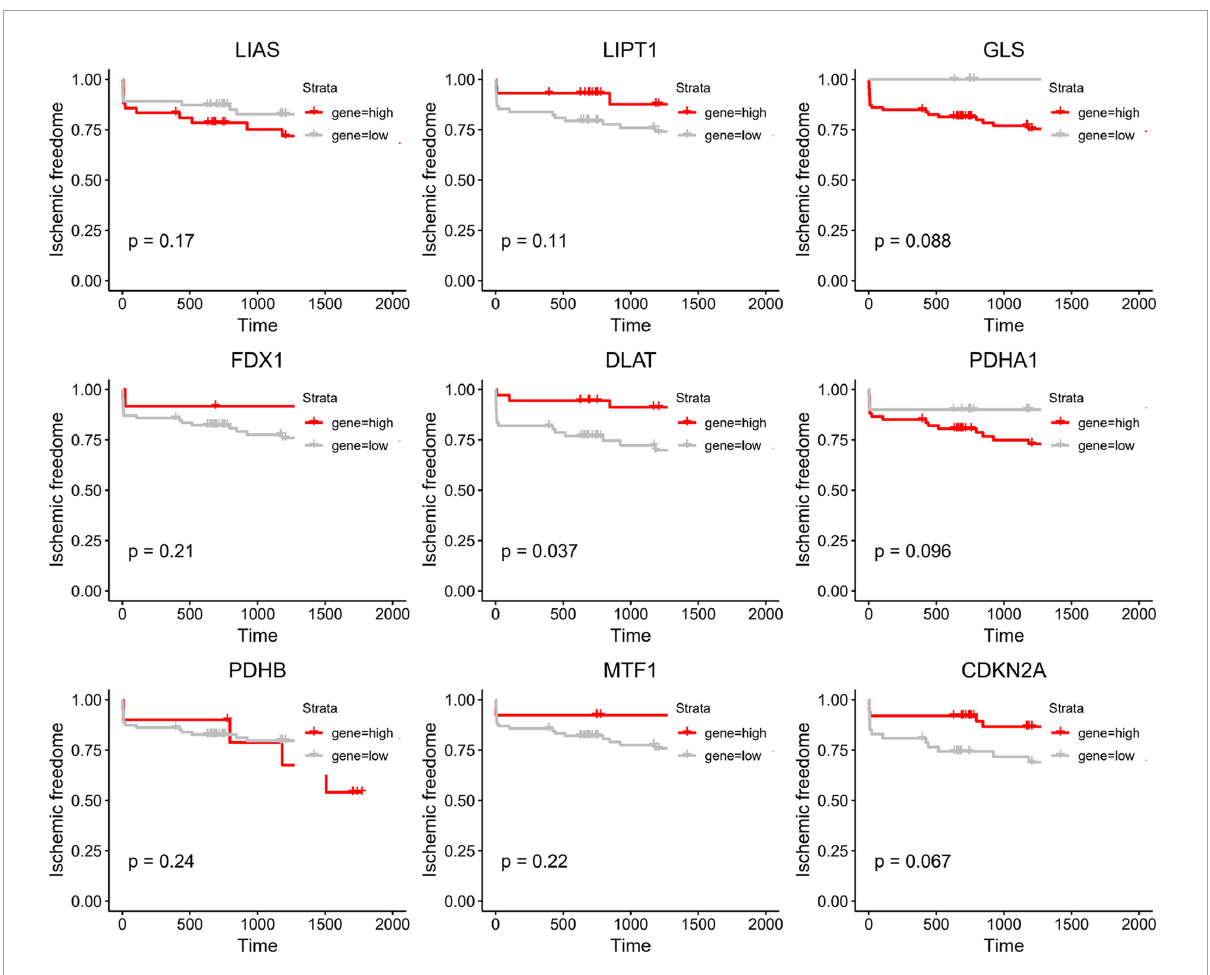
FIGURE6 Kaplan–Meier curve of cuproptosis-related genes